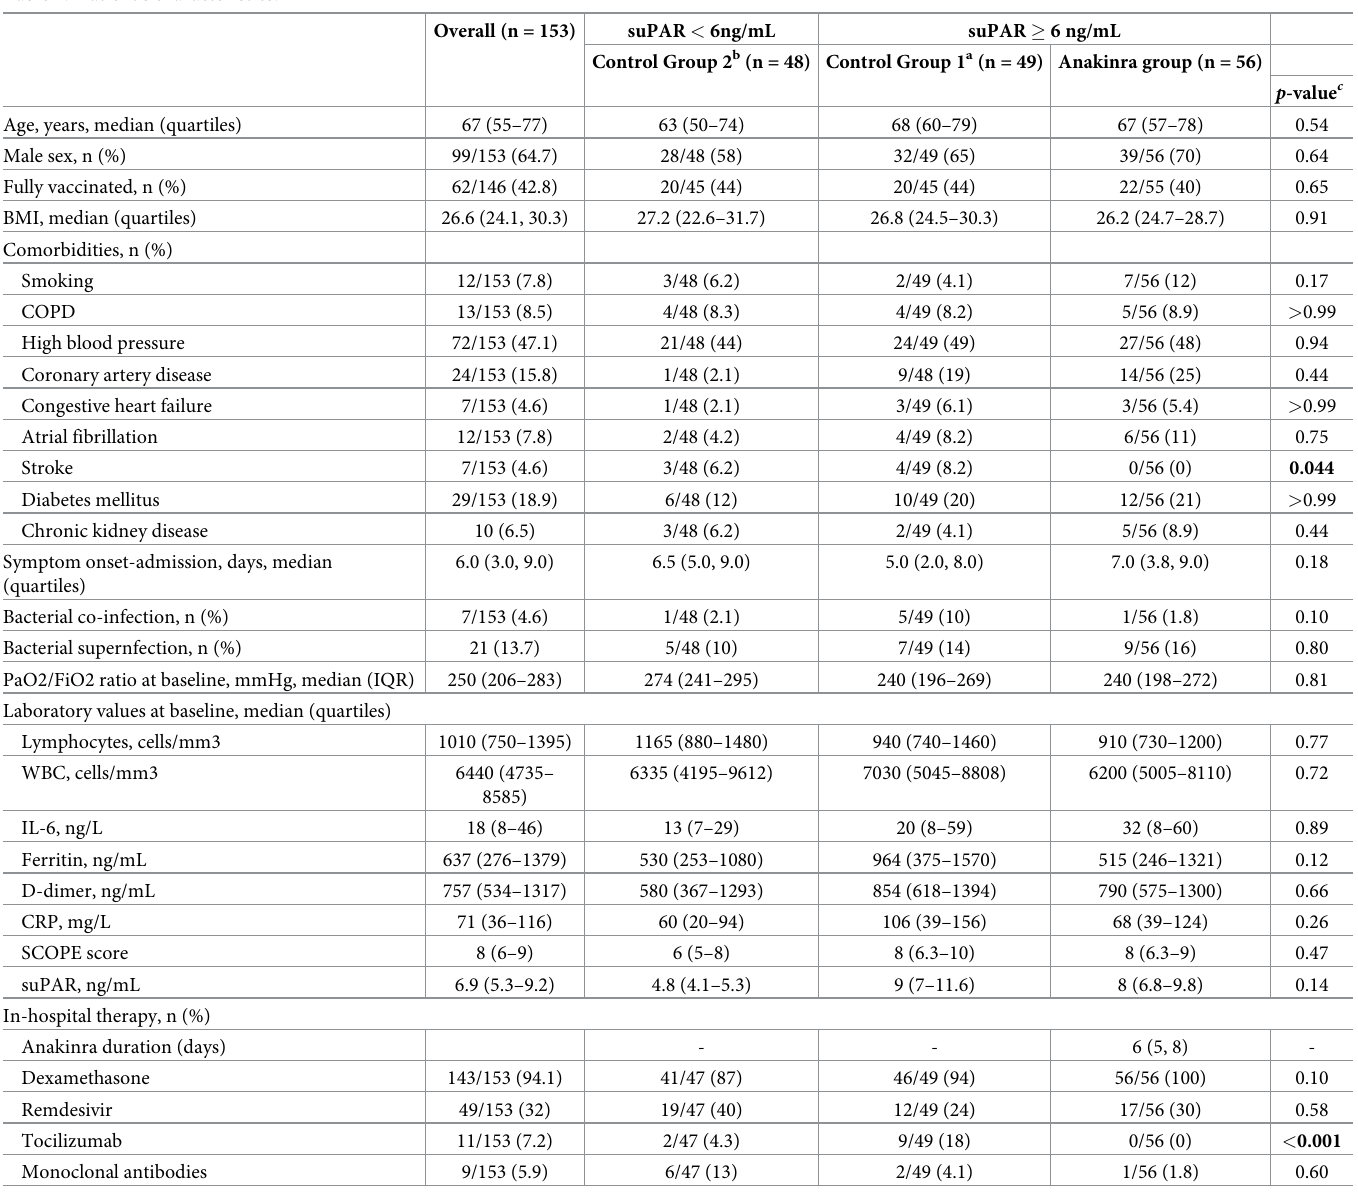
Table 1. Patient’s